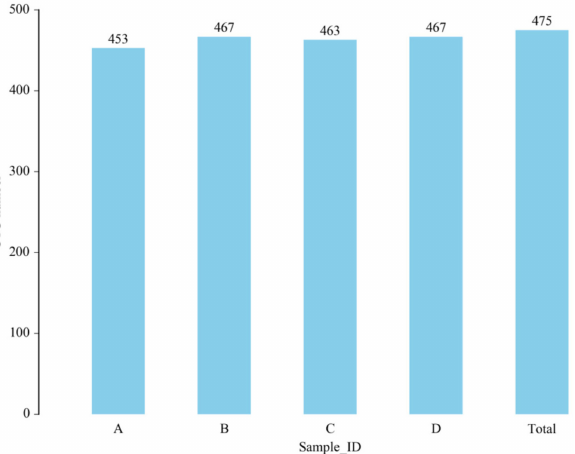
Figure 6. Number of OTUs. Note: A: CON group, B: L.S group, C: E. coli group, D: L.S + E. coli group.